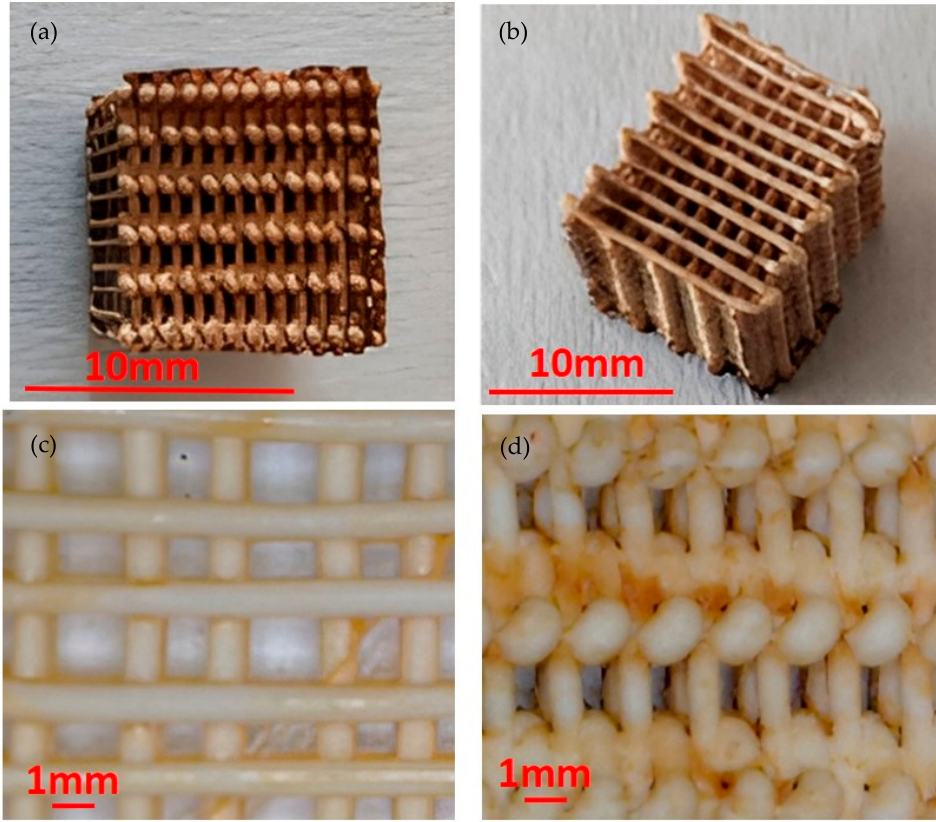
Figure 1. ( a ): Top view of the catalyst; ( b ) side view of the catalyst; ( c ) detail of a midplane section parallel to the building direction in 3D printer; ( d ) detail of a side view.